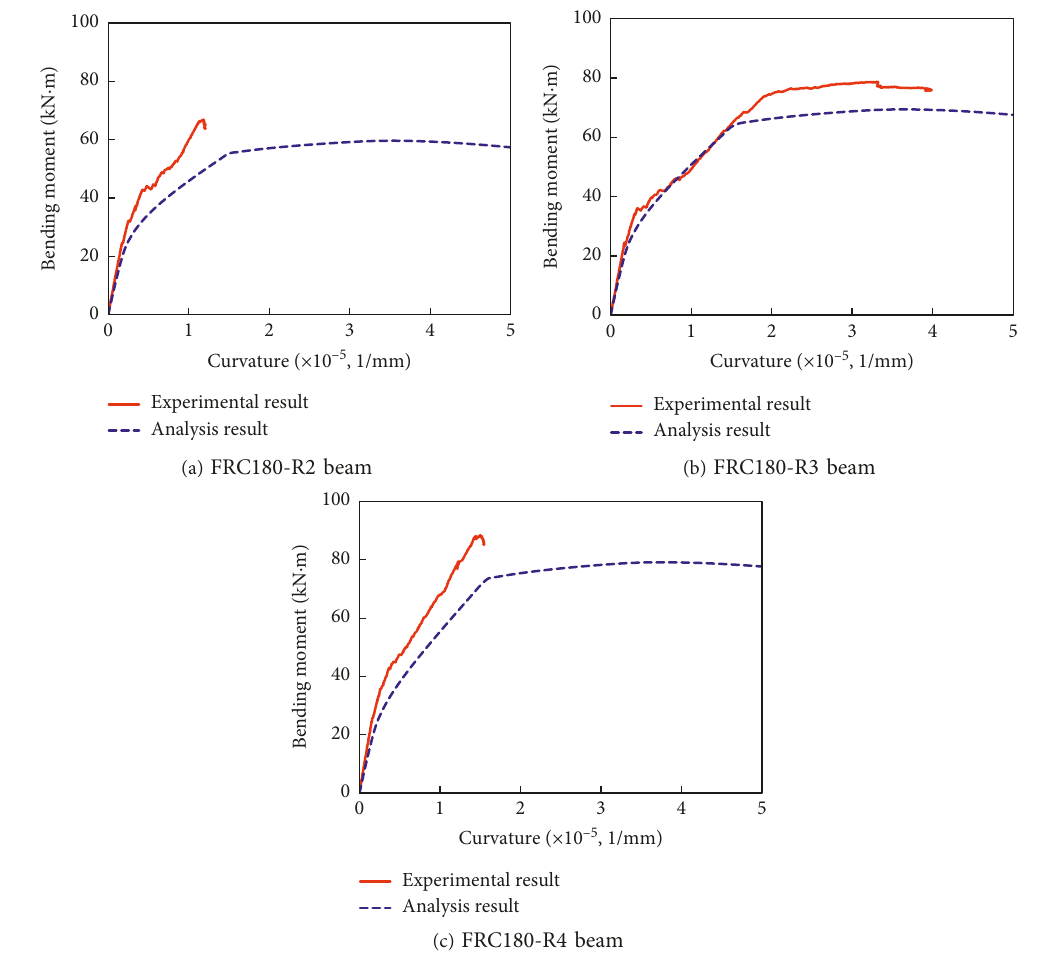
Figure 14: Prediction of moment-curvature curves (FRC180 series beams). Table 5: Analysis